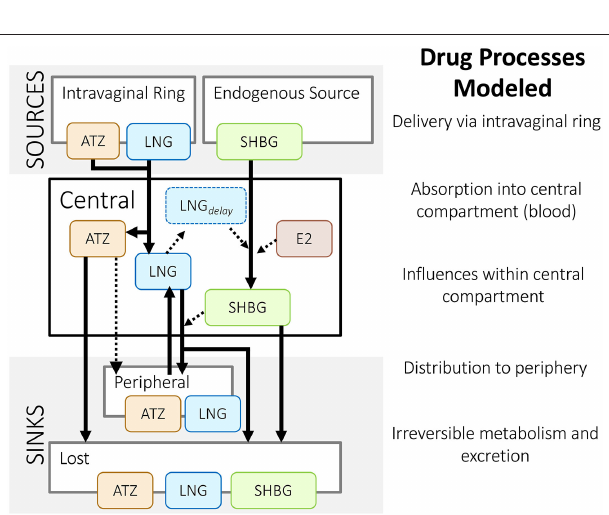
FIGURE 5 | Structure of Reinecke et al.’s (26) population pharmacokinetic models for an intravaginal ring that delivers anastrozole (ATZ) and levonorgestrel (LNG). These models include the influence of estradiol (E 2 ) and LNG on sex hormone binding globulin (SHBG), and vice versa. Solid lines represent a mass flow; dashed lines represent an indirect influence – as described in Reinecke et al.